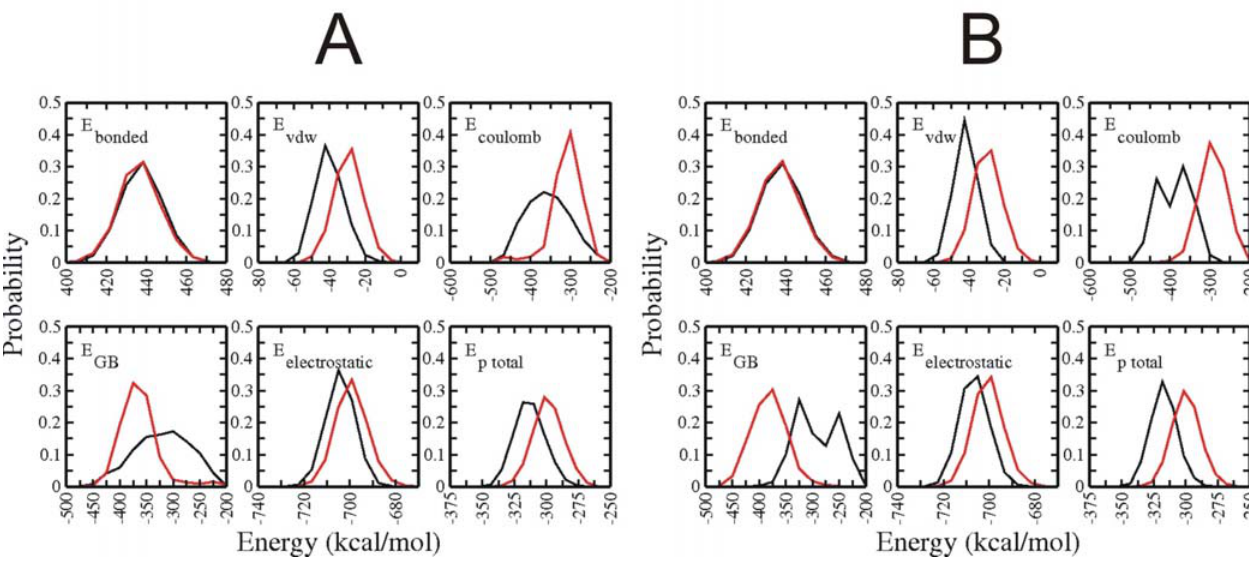
Figure 7. (A) Distribution of potential energy components to the force field comparing the first 5 ns (red line) and the last 5 ns (black line) of the BP-RexMD simulation (reference includes all energy contributions due to replica under control of original force field). E bonded represents the Lenard- bond length, bond angles and dihedral angles in the protein. E vdw Jones part of the force field energy. The E corresponds to the sum of Coulomb electrostatic energy (E ) and electrostatic solvation based on a Generalized Born model (E ). (B) Coulomb GB of 4.5 Å from the native same as in (A) except for conformations with a minimum Rmsd C α structure representing unfolded structures (red line) or maximum Rmsd of 2.0 Å from the C α native structure representing folded structure (black